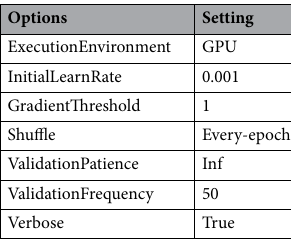
Table 3. Network training